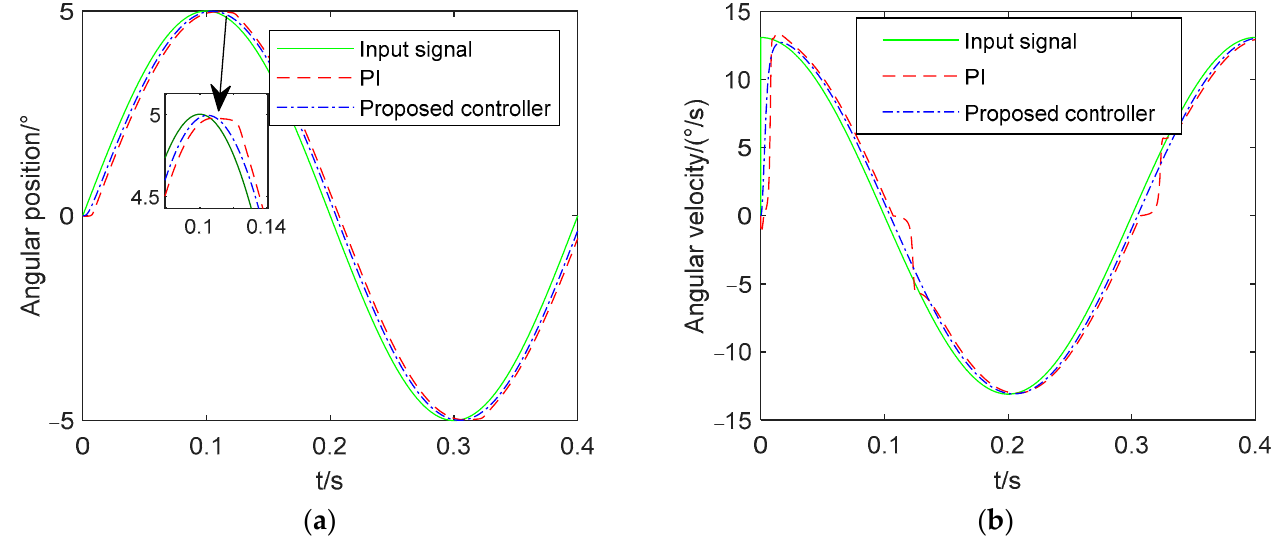
Figure 15. Response of 5sin (5 π t) ( a ) Position tracking curve; ( b ) Speed tracking curve.